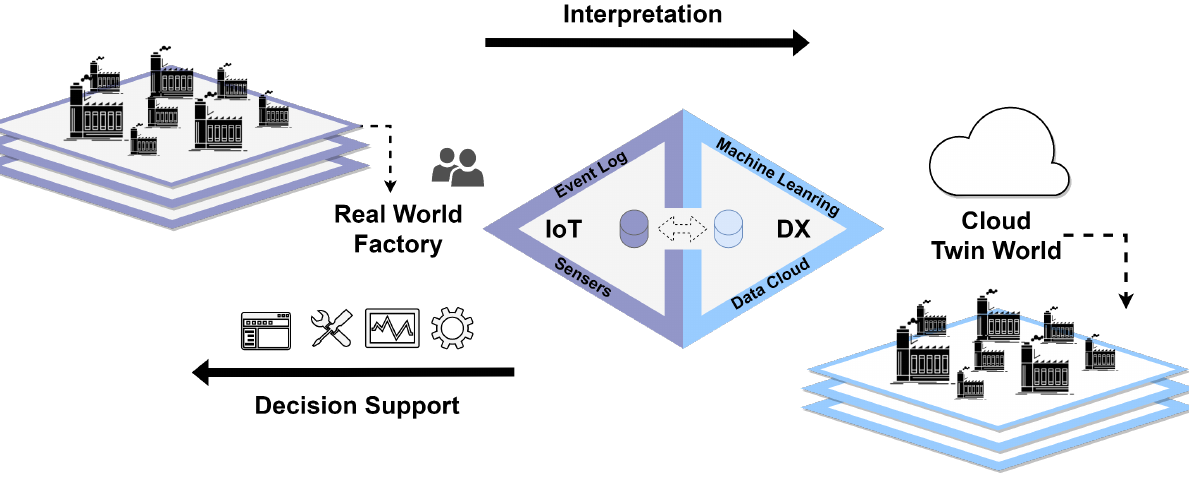
Figure 1. Digital twin